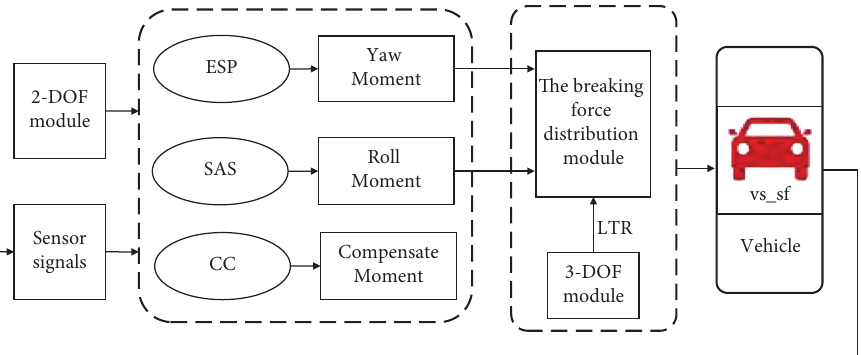
Figure 4: Block diagram of coordination controller.